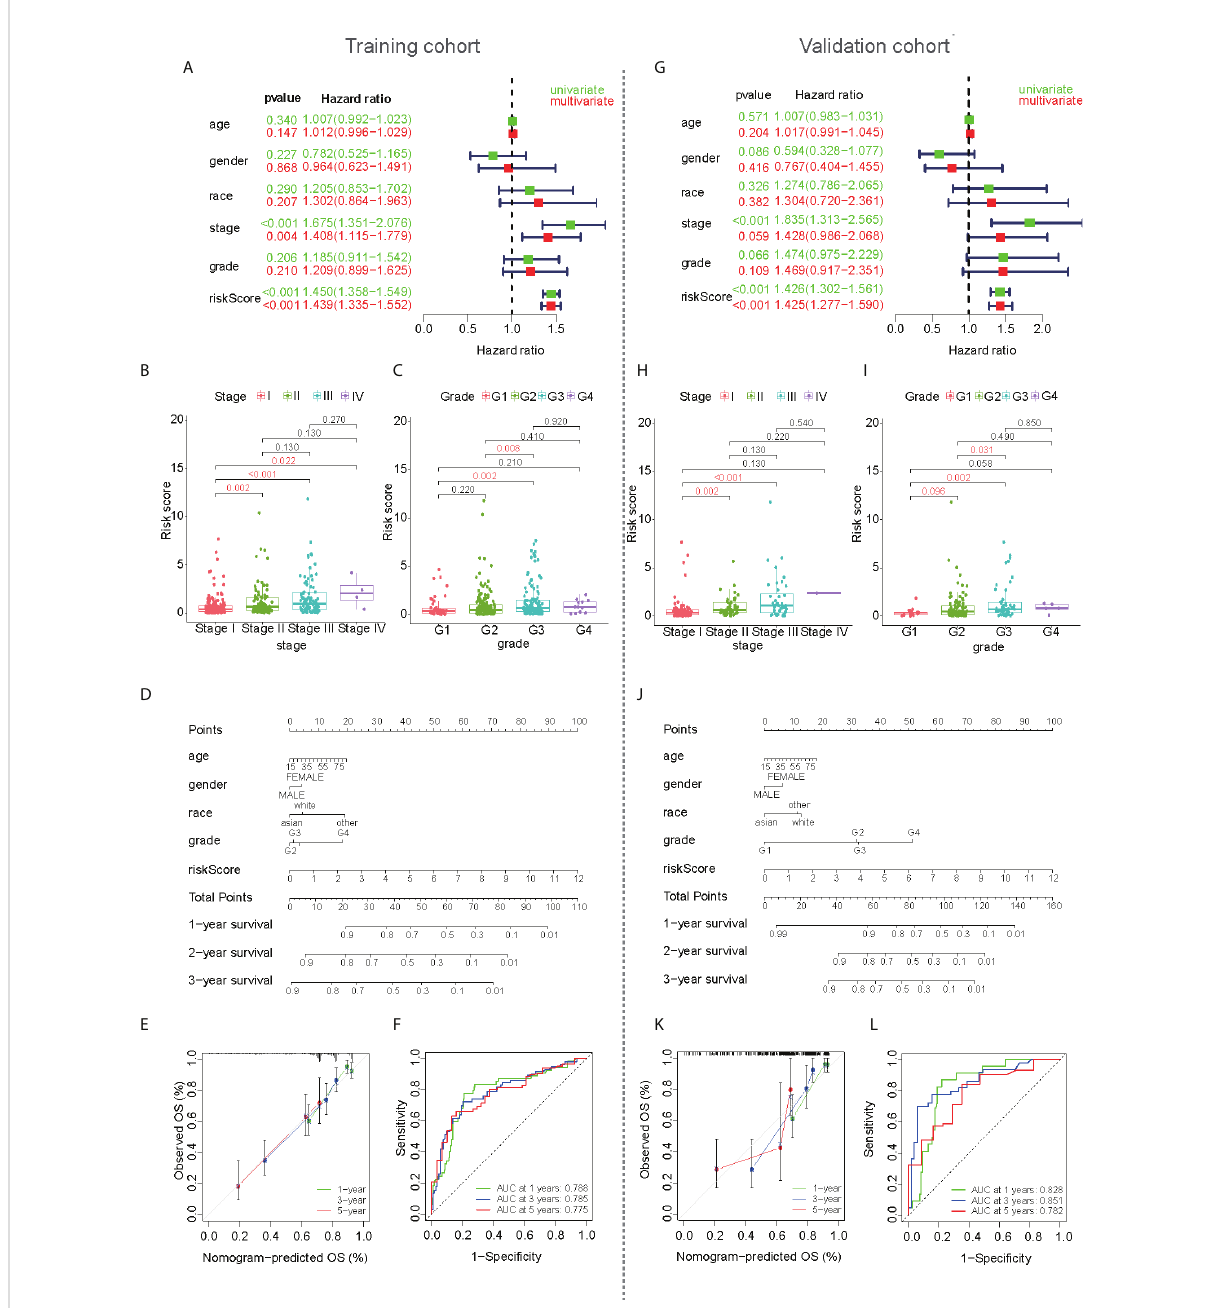
FIGURE 4 Development of a nomogram based on mfrlncRNA signature used to predict the survival of HCC patients. (A) Cox regression for the mfrlncRNA signature in the training cohort. Red represents multivariate Cox regression and green represents univariate Cox hazard ratio analysis. (B, C) The differences in stage (B) and tumor grade (C) between high- and low-risk populations in the training cohort. (D) Nomogram for predicting the 1-, 3-, and 5-year overall survival of patients with HCC in the training cohort. (E) Calibration curve for predicting OS in the training cohort. (F) The 1-, 3-, and 5-year ROC of the nomogram model were 0.788, 0.785, and 0.775 in the training cohort, respectively. (G – L) The development of a nomogram in the validation cohort. HCC, hepatocellular carcinoma; ROC, receiver operating characteristic